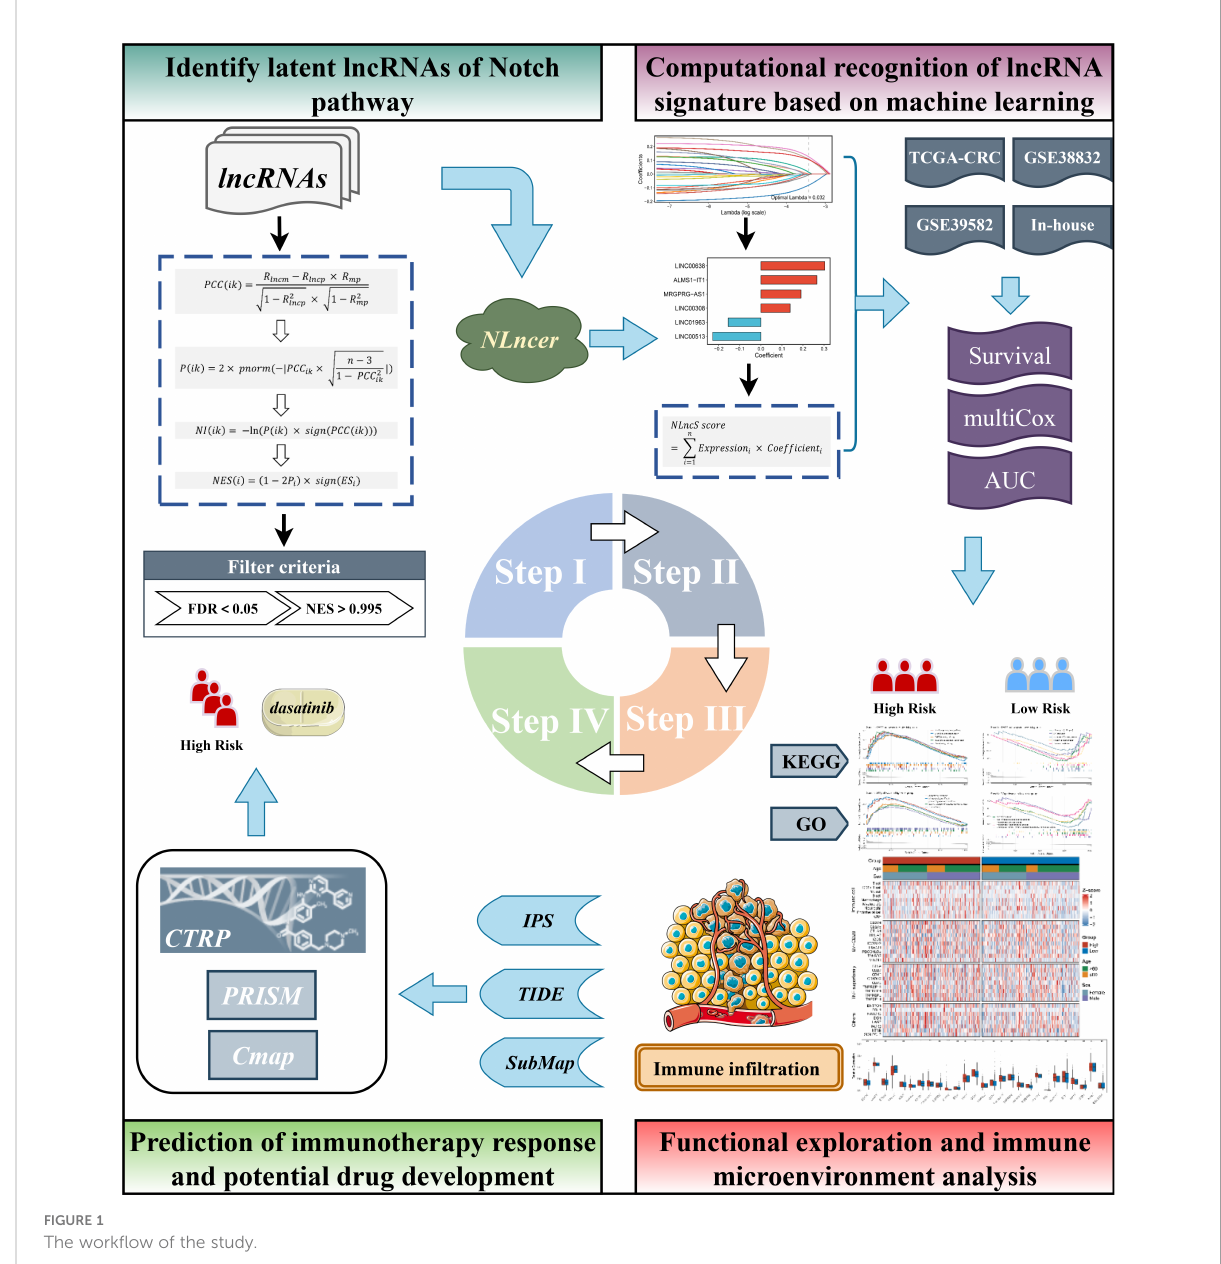
FIGURE 1 The work fl ow of the